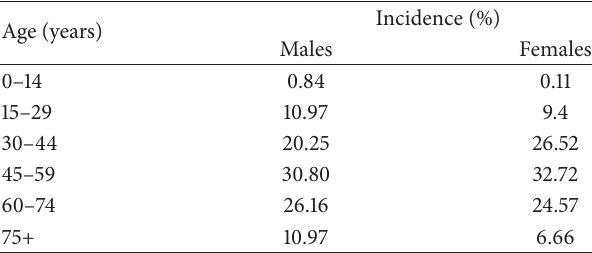
Figure 2: Trends of mean age at disease onset and death. Table 1: Age-class incidence